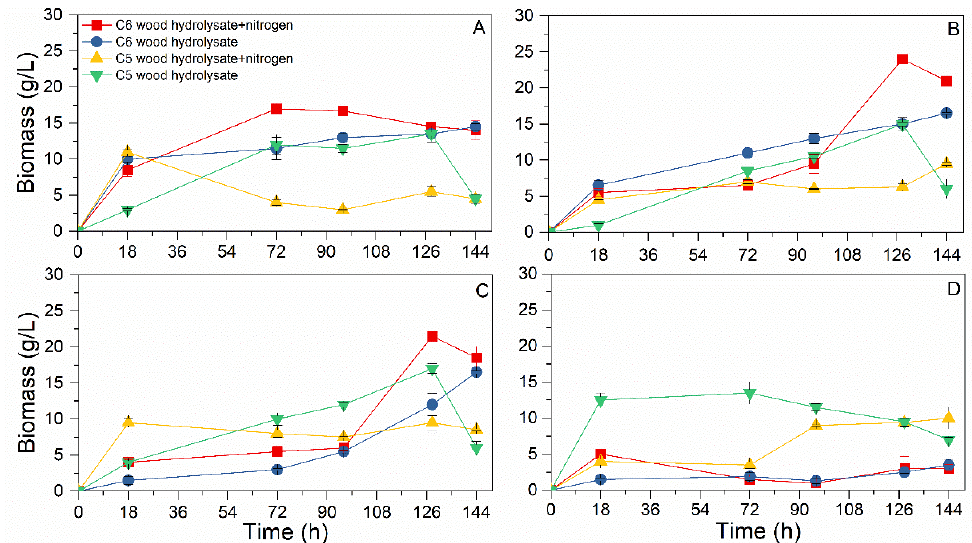
Figure 2. Biomass production by R. toruloides -1588 using wood hydrolysate as a culture media. A) 50 g/L; B) 75 g/L; C) 100 g/L; D) 120 g/L. ( A ) 50 g/L; ( B ) 75 g/L; ( C ) 100 g/L; ( D ) 120